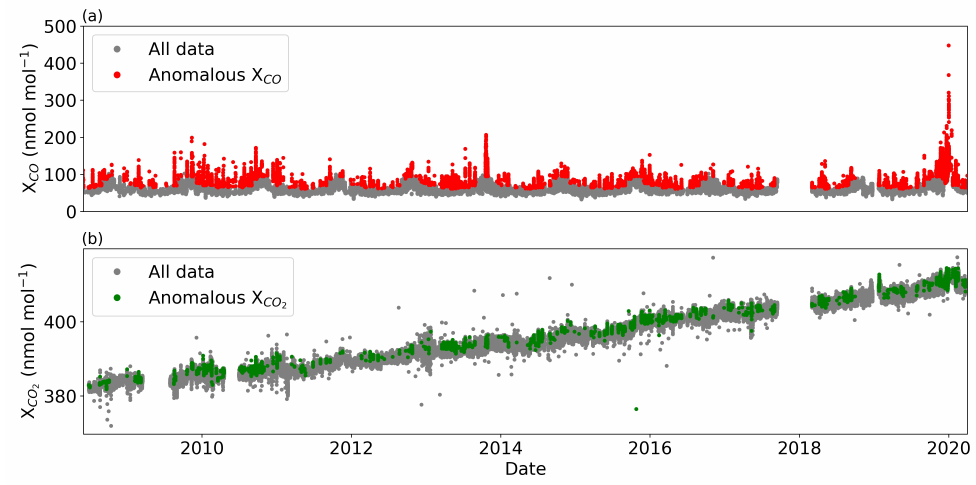
Figure 6. Time series of ( a ) TCCON and NDACC X CO anomalous values (Median + 3Median Absolute Deviation); ( b ) corresponding measurements of X CO2 (TCCON) from July 2008 to June 2020 at